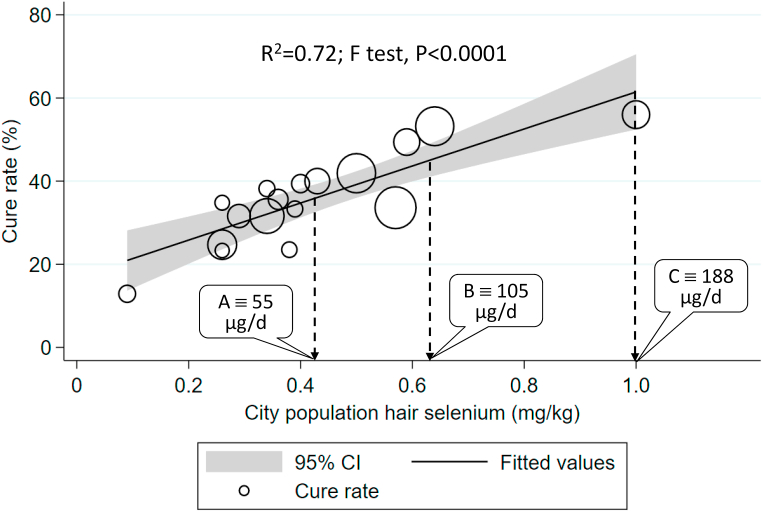
Correlation between COVID-19 cure rate in 17 cities outside Hubei on Feb 18, 2020, and city population selenium status (hair selenium concentration) analysed using weighted linear regression. Each data point represents the cure rate, calculated as percentage of patients hospitalized with SARS-CoV-2 deemed to be cured*. The size of the marker is proportional to the number of cases (adapted from Am J Clin Nutr [7] with permission). From the graph of Se intake vs hair Se concentration, Supplemental Figure 1, Seintake = 232.98 Sehair – 44.521,allowing the calculation of corresponding values of selenium intake and hair concentration (Supplemental Table 3). Thus value A represents the hair concentration corresponding to an intake of 55 µg/d where platelet GPX1 activity is maximised [58], value B represents the hair concentration corresponding to an intake of 105 µg/d where SELENOP concentration is maximised [58], and value C is the hair selenium concentration (1.0 mg/kg) at the maximum cure rate in the investigated cities which corresponds to an intake of 188 µg/d.*Cured patients are those in whom temperature has returned to normal for more than 3 days, respiratory symptoms are significantly improved, lung imaging shows significant reduction of inflammation, negative nucleic acid test of respiratory pathogen on two consecutive occasions with a sampling interval of at least 1 day.